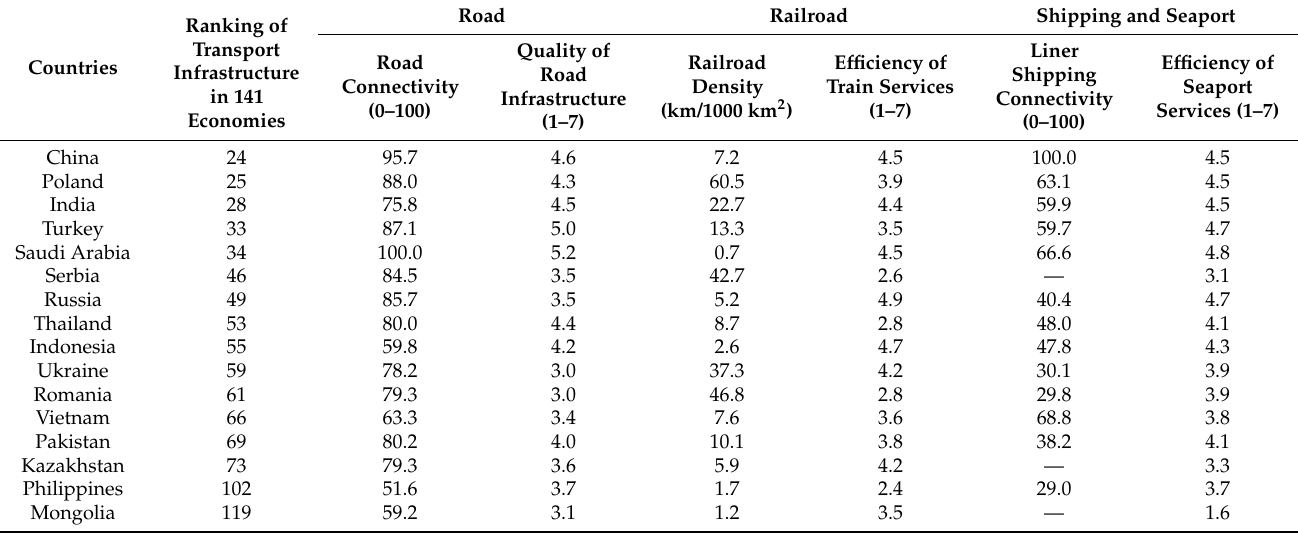
Table 5. The traffic infrastructure conditions in main countries along the B&R and China in